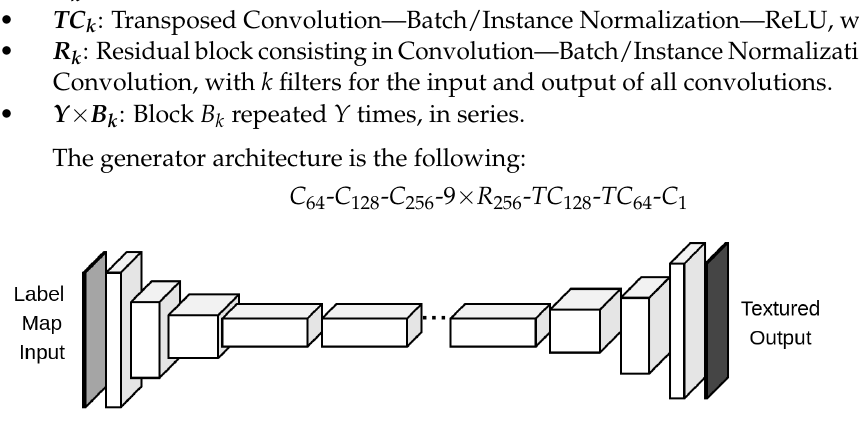
Figure 1. ResGAN architecture